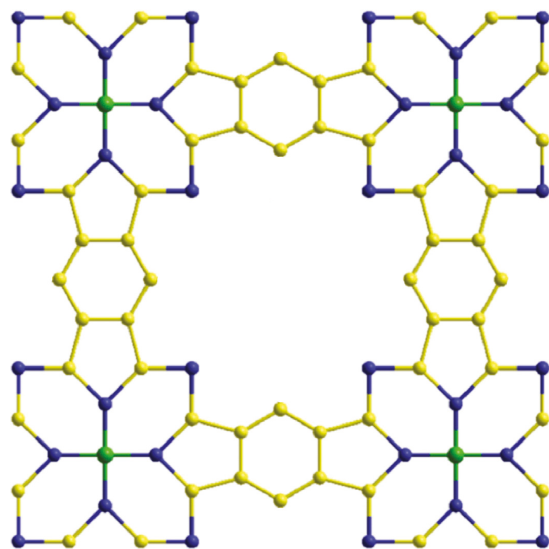
Figure 2: Transition metal tetra-cyano-benzene organic network type-I.